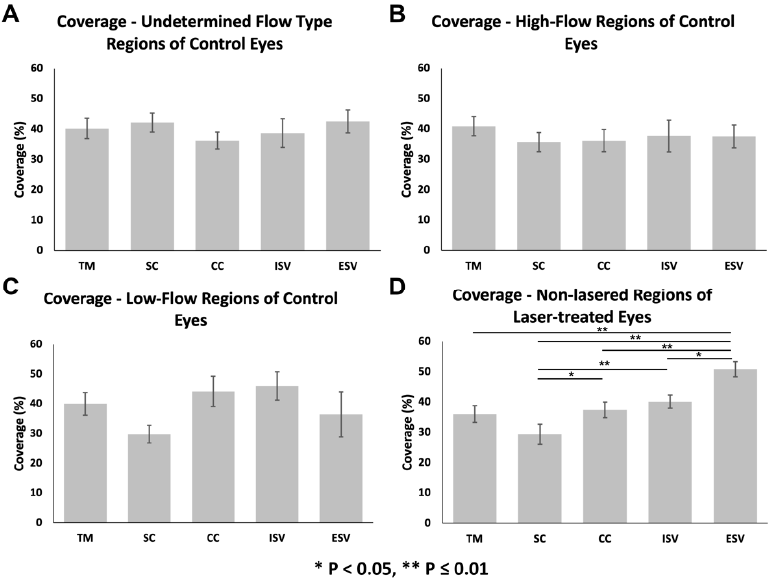
n = 44) was significantly lower than ESVs (50.9 ± 2.5%; n = 46; p ≤ 0.01); coverage of SC